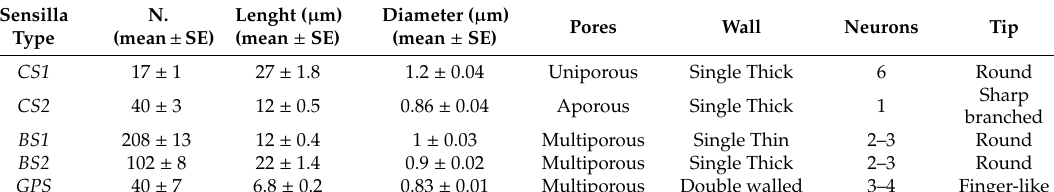
Table 4. Morphological features of antennal sensilla in S. zeamais .